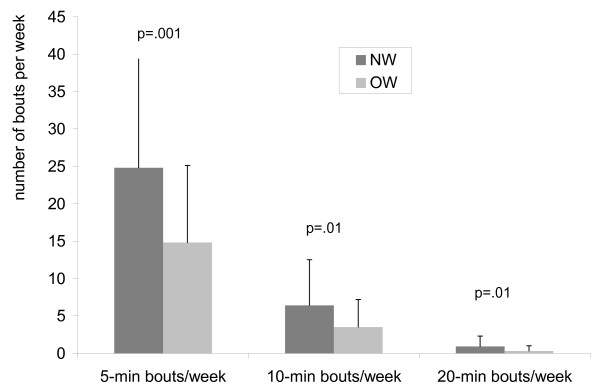
Number of 5-min, 10-min and 20-min bouts of MVPA in NW and OW children.